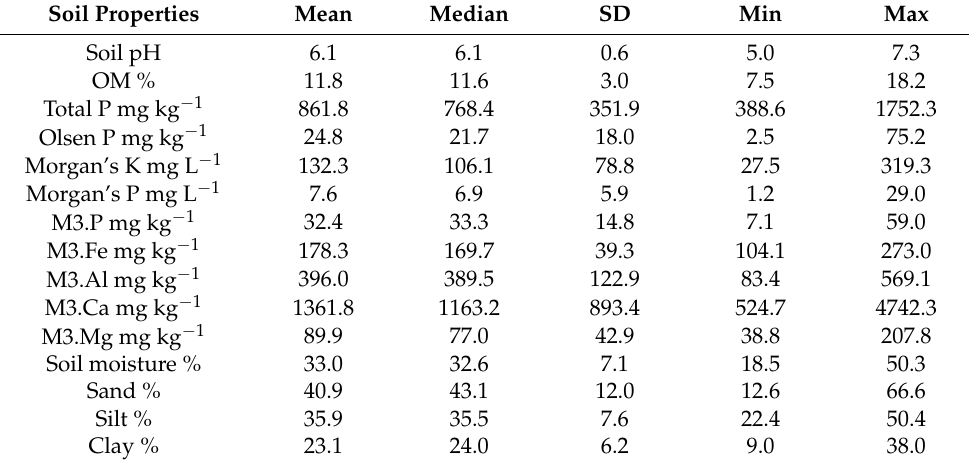
Table 1. Summary statistics of soil properties, soil pH, organic matter (OM), soil moisture and soil texture, agronomic Morgan’s extractable phosphorus (Morgan’s P) and potassium (Morgan’s K),